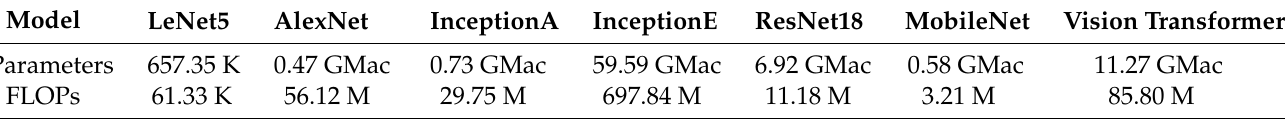
Table 3. Total number of parameters and floating point operations for each